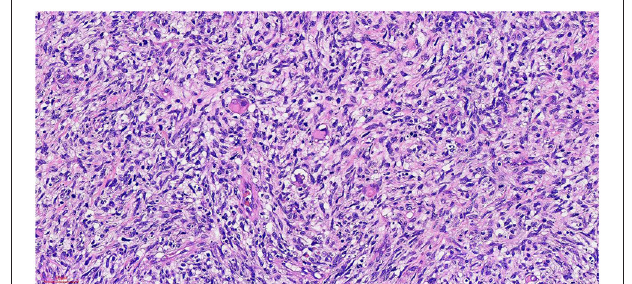
FIGURE 5 | He x 20: The tumor cells were arranged in fascicles, and some were nestled in some areas. The nucleus was fusiform and oval, and the cytoplasm was rich and acidophilic.